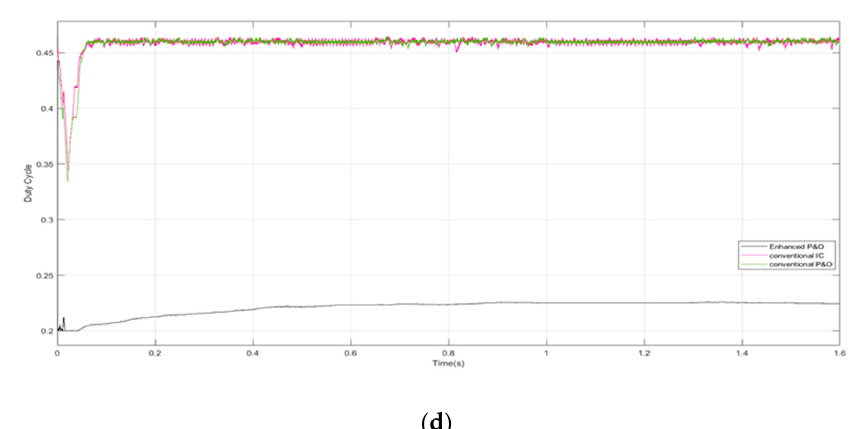
Figure 17. ( a ) Scenario of case “a” of the (8S) PV array; ( b ) The extracted power by the proposed technique and the conventional P&O and IC techniques; ( c ) The voltage at the boost converter output; ( d ) The duty cycle behaviors.